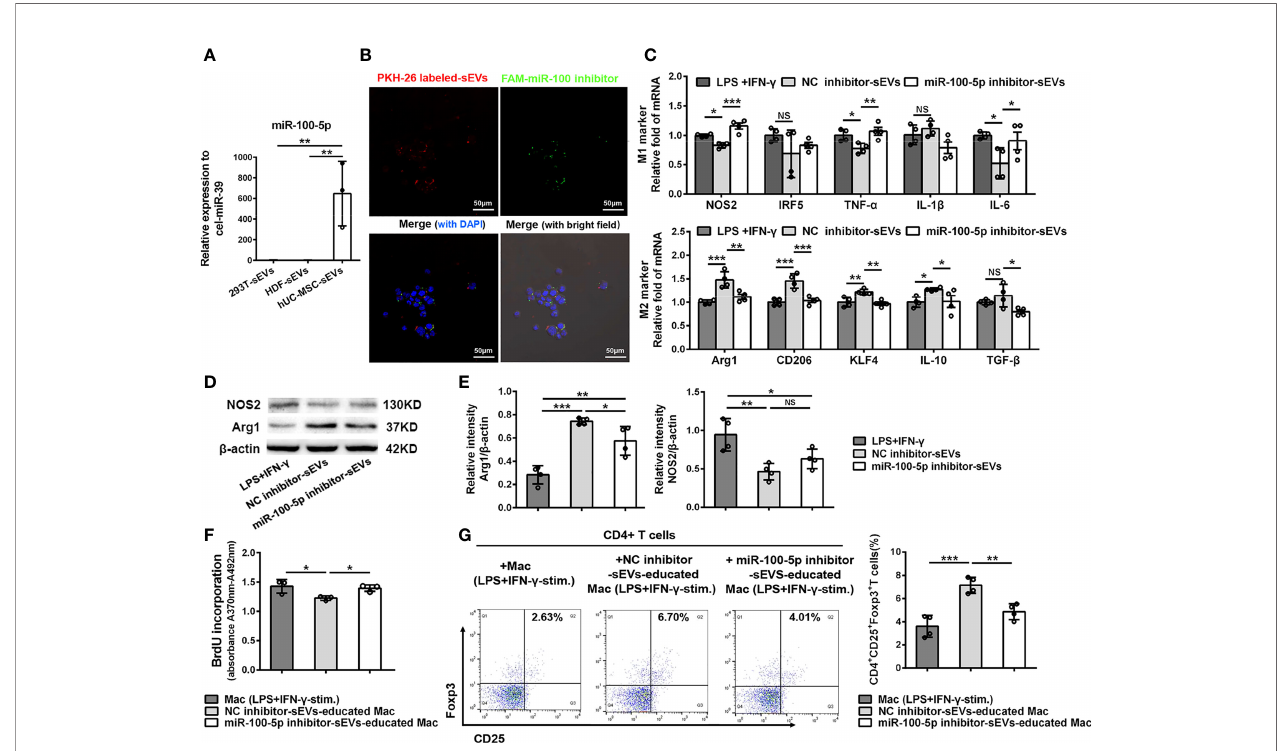
FIGURE 7 | miR-100-5p transferred by hUC-MSC-sEVs modulated macrophage phenotype and function. (A) Q-PCR analysis of miR-100-5p levels in hUC-MSC- sEVs, 293T-sEVs and HDF-sEVs. (B) Representative images of the internalization of miR-100 inhibitor transfected (green) PKH-26-labeled hUC-MSC-sEVs (red) by THP-1 derived macrophages (DAPI blue). (C – E) LPS+IFN- g -stimulated Mac was co-cultured with miR-100-5p inhibitor-sEVs or NC inhibitor-sEVs for 48h. (C) Q- PCR analysis of M1 markers (NOS2, IRF5, TNF- a , IL-1 b and IL-6) and M2 markers (Arg1, CD206, KLF4, IL-10 and TGF- b ). (D, E) Protein analysis for NOS2 and Arg1. (F, G) THP-1 derived macrophages pretreated with miR-100-5p inhibitor-sEVs or NC inhibitor-sEVs were co-cultured with human CD4+ T cells stimulated by anti-CD3/-CD28. (F) BrdU assay for CD4+ T cell proliferation. (G) Flow cytometry for CD4+CD25+Foxp3+ T cells. sEVs, hUC-MSC-sEVs; LPS+IFN- g -stim., LPS +IFN- g -stimulation. NC, negative-control. Representative data from at least three independent experiments were presented as mean± SD. *P < 0.05, **P < 0.01, ***P < 0.001, NS, not signi fi